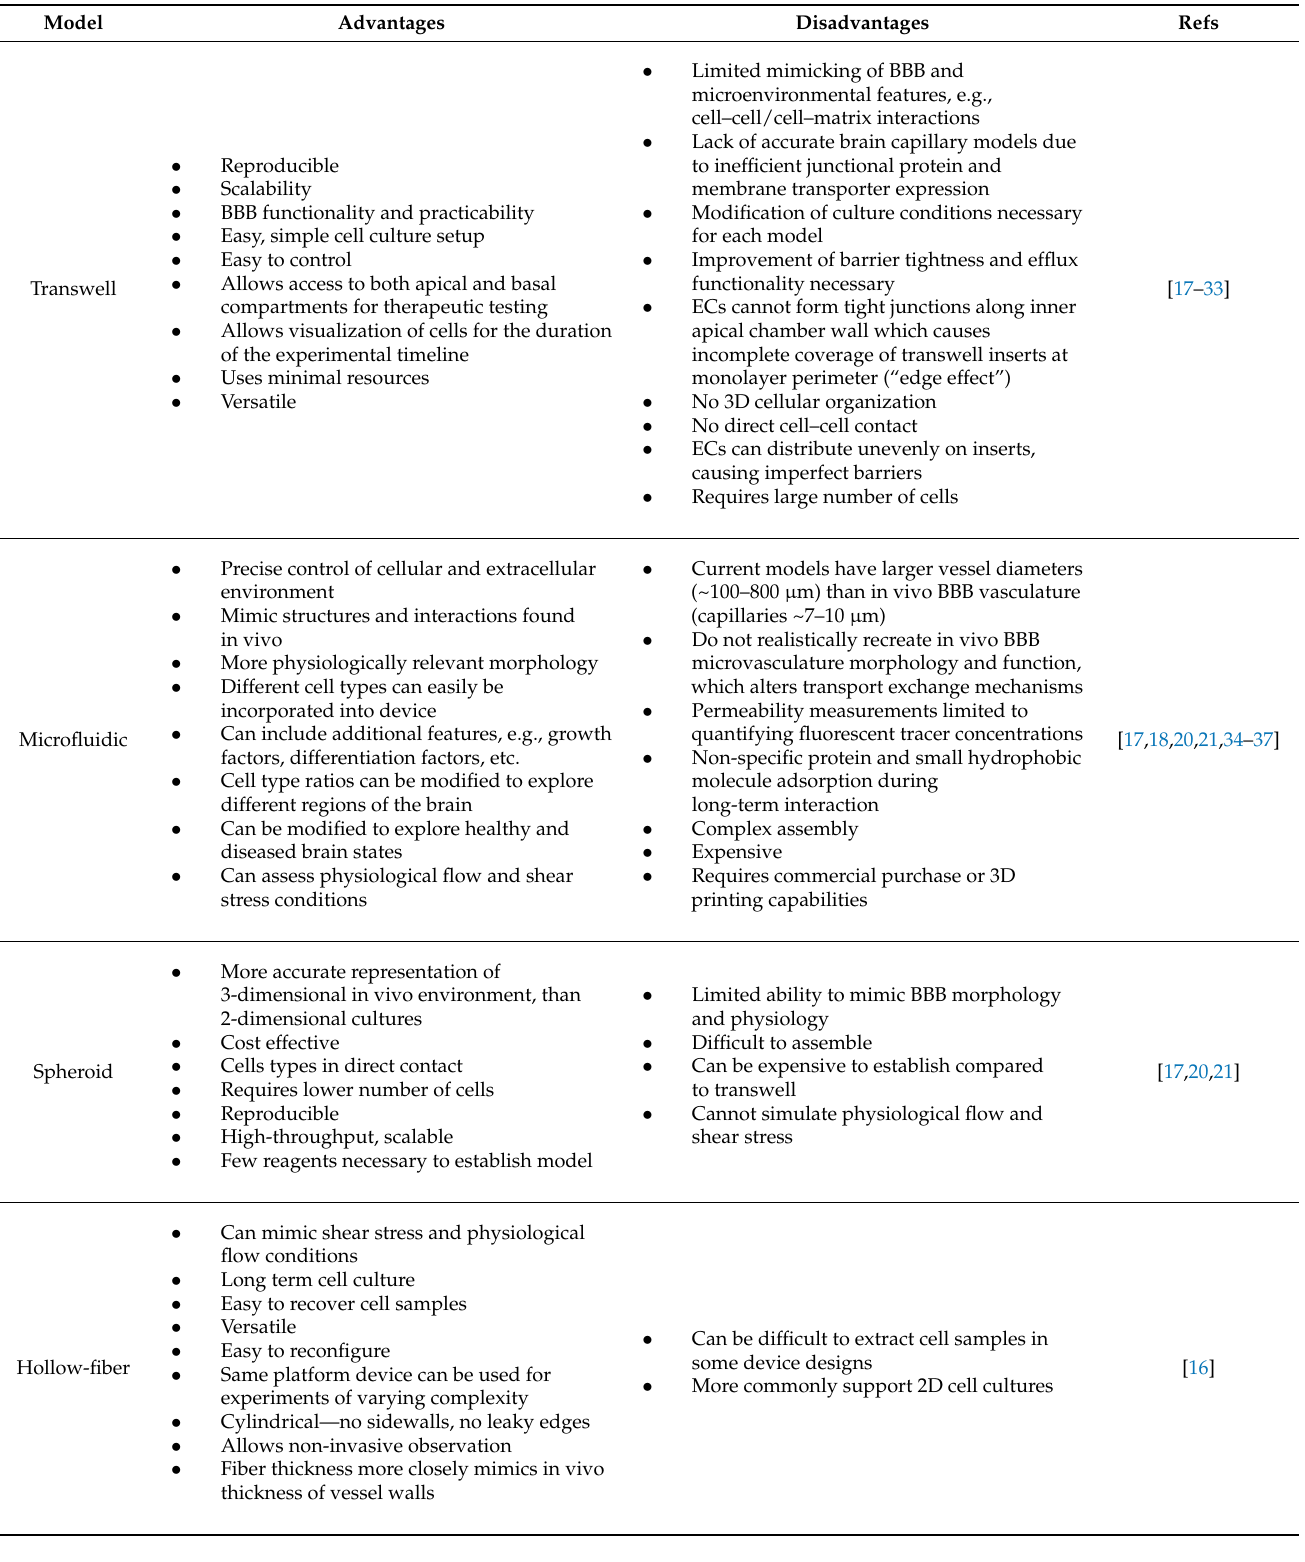
Table 1. Advantages and disadvantages of in vitro BBB/BBTB